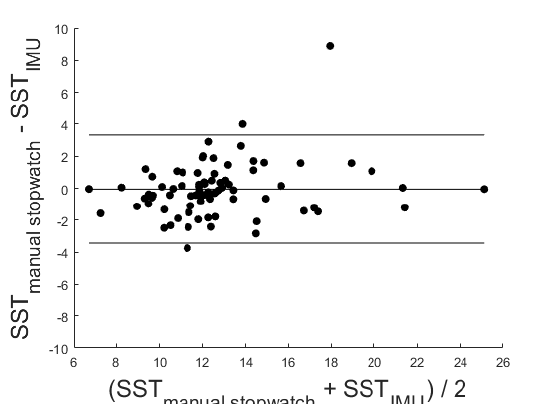
Figure 11. Linear regression among manual stopwatch measurements and the USS sensor belt (IMU) measurements for the SST.